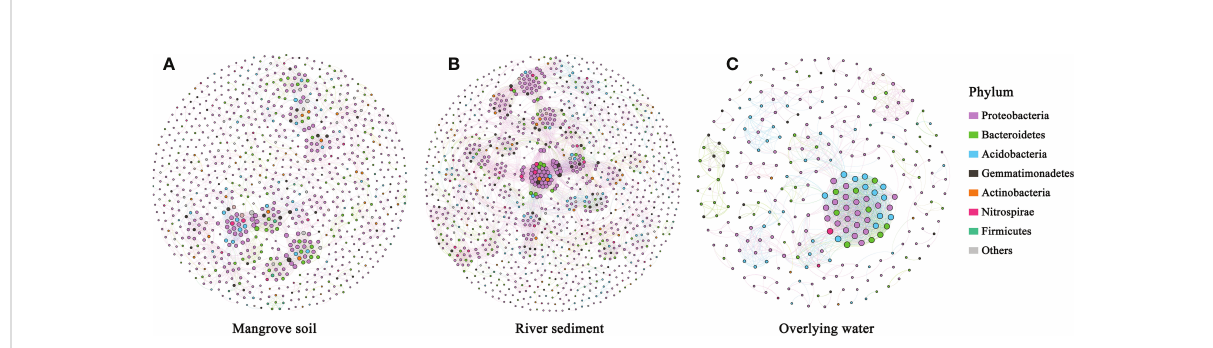
FIGURE 6 The co-occurrence networks of bacterial communities colored by phylum in mangrove soil (A) , river sediment (B) and overlying water (C) microhabitats.